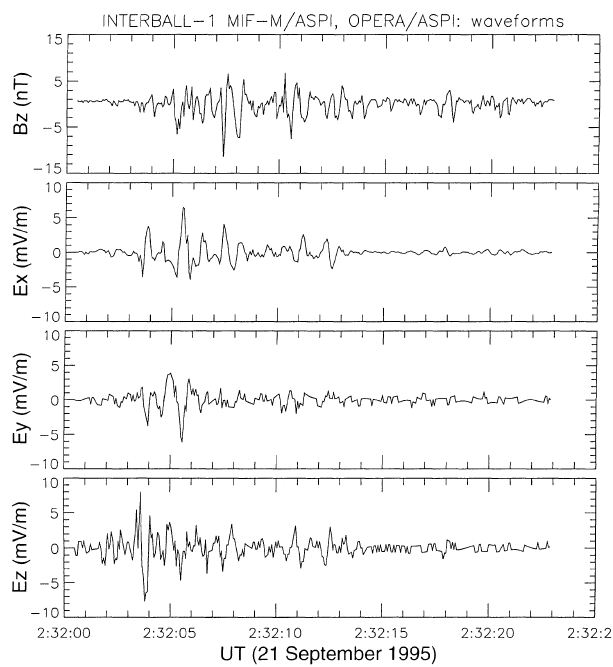
Fig. 11. Low-latitude boundary crossing 21 September 1995. Wave- form snapshots. From top to bottom : B z magnetic field: E x ; E y ; E z electric field waveform components in the spacecraft frame of reference (see text